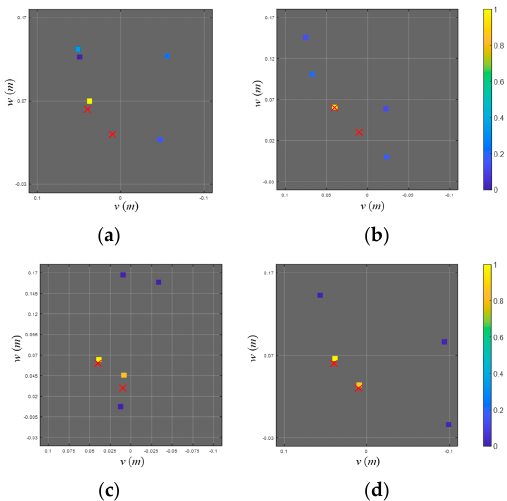
Figure 8. ( a – c ) Localization results using the off-grid BSBL with grid intervals 0.10 m, 0.05 m, and 0.25 m. Computational times measured from the localization processes were approximately 9 s, 56 s, and 50 min, respectively, with a CPU i9-10900K. ( d ) Localization results using the pairwise off-grid BSBL with a grid interval 0.10 m. Computational time measured from the localization process was approximately 29 s. Table 1. Localization results of adjacent noise sources along with various schemes.